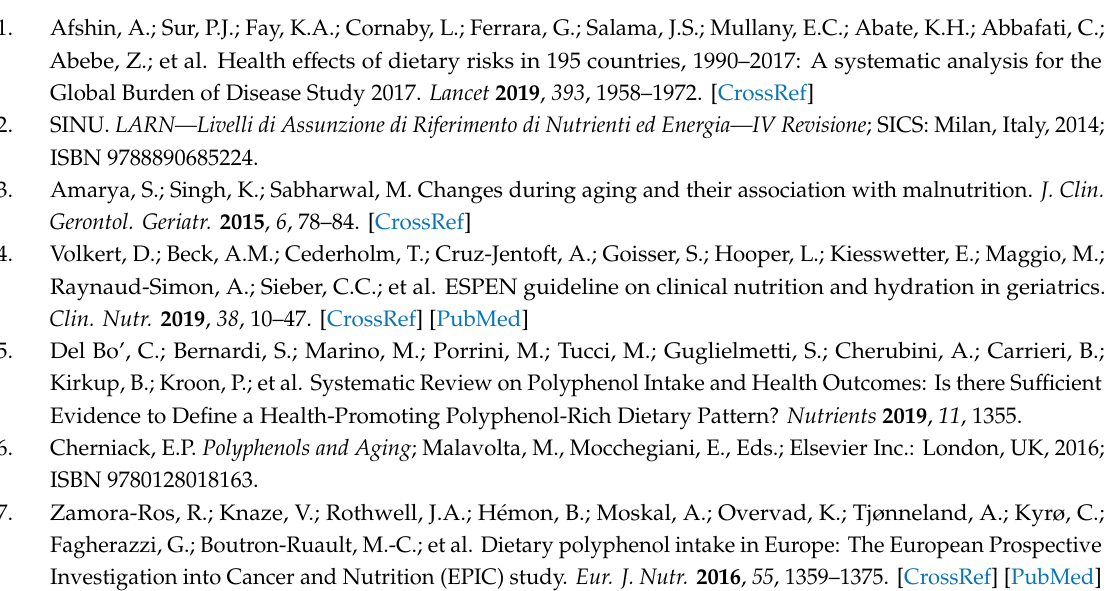
Figure S1: comparison of percentage energy and nutrient intake during 8-week polyphenol-rich diet (PR-diet) and control diet (C-diet) in older women and